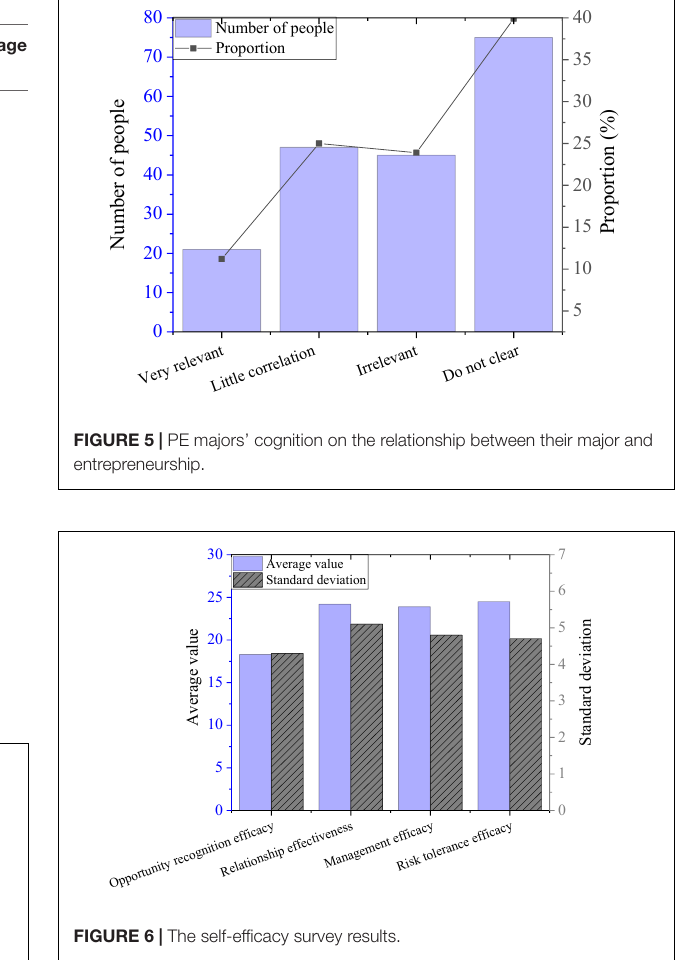
TABLE 1 | Basic information of research subjects.